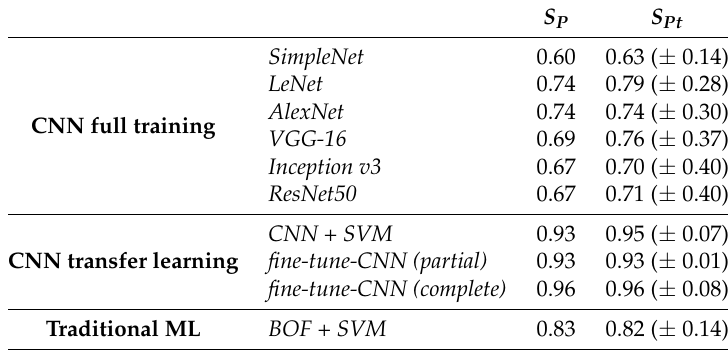
Table 3. Classification accuracy: patch and patient scores (mean ± std). BOF, Bag Of